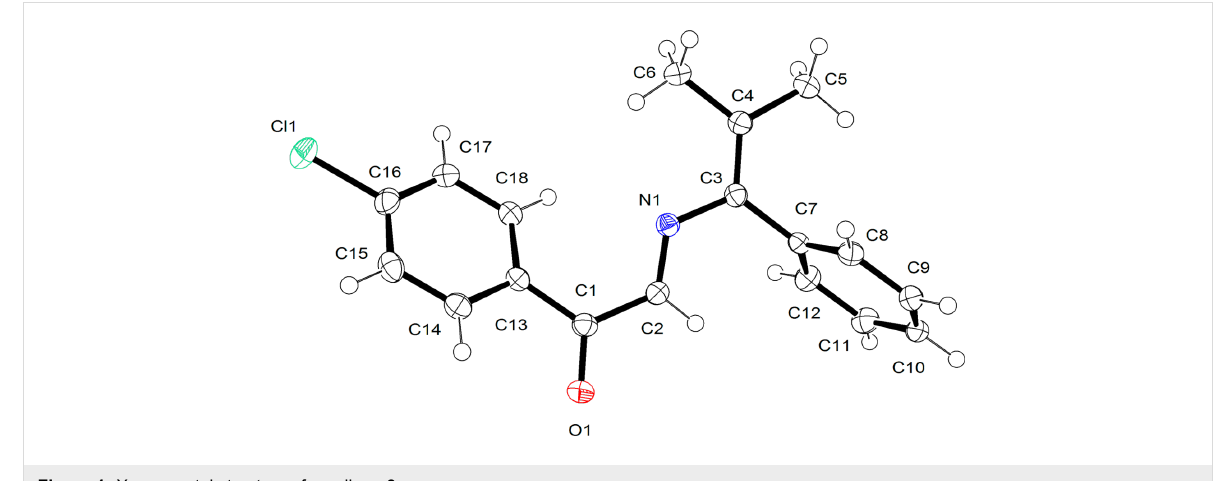
Figure 1: X-ray crystal structure of azadiene 3e .